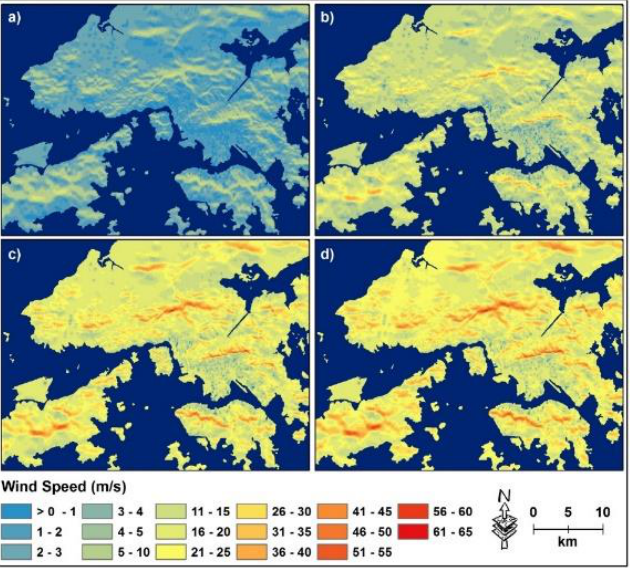
Figure 5. Wind speed measured in Hong Kong (18 September 2018) using the Airflow Analyst at different ground heights: ( a ) 1 m, ( b ) 9 m, ( c ) 22 m and ( d ) 30 m.